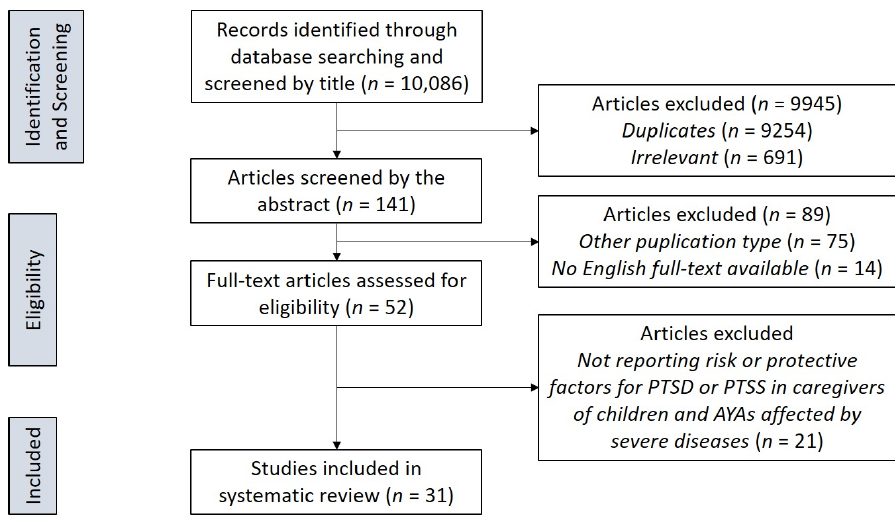
Figure 1. PRISMA (Preferred Reporting Items for Systematic reviews and Meta-Analyses) flowchart of the study selection process.